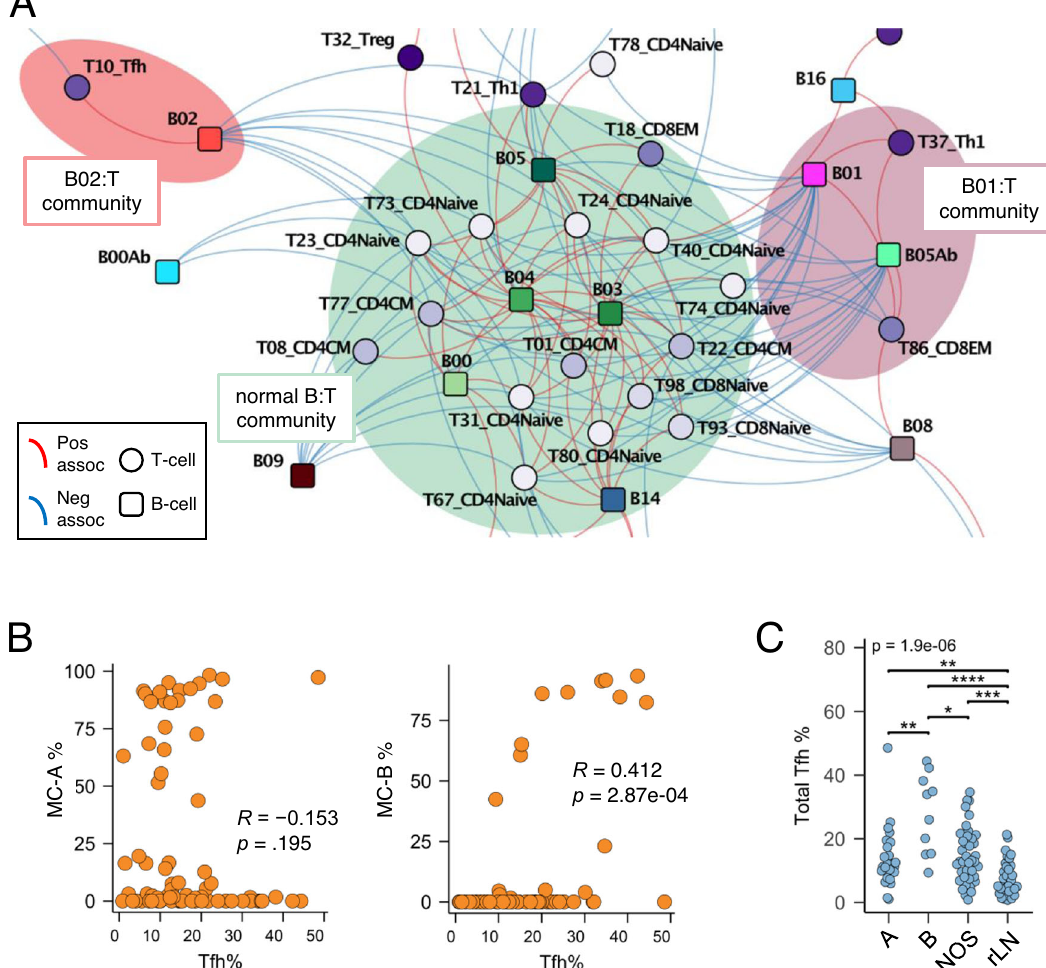
Fig. 5 | B-cell types are associated with distinct subsets of T-cells. A B/T-cell cluster co-occurrence network by force-directed graphing as in Fig. 3B. Probabil- istic model-based co-occurrence analysis (2-sided test) was performed using B/T- cell cluster information from 73 FL and 34 rLN samples without additional adjust- ment for multiple testing (see Methods). Each node represents a B- or T-cell PG cluster. Each B-cell cluster is colored separately; T-cell clusters are colored according to landmark group. Communities local to normal B-cells and tumor B-cell clusters B01 and B02 are shown; see Supplementary Data 10 for the full network image. B Cell abundance correlation plots. Each dot represents an indi- vidual sample. B- and T-cell cluster % values are among total B- and T-cells in each